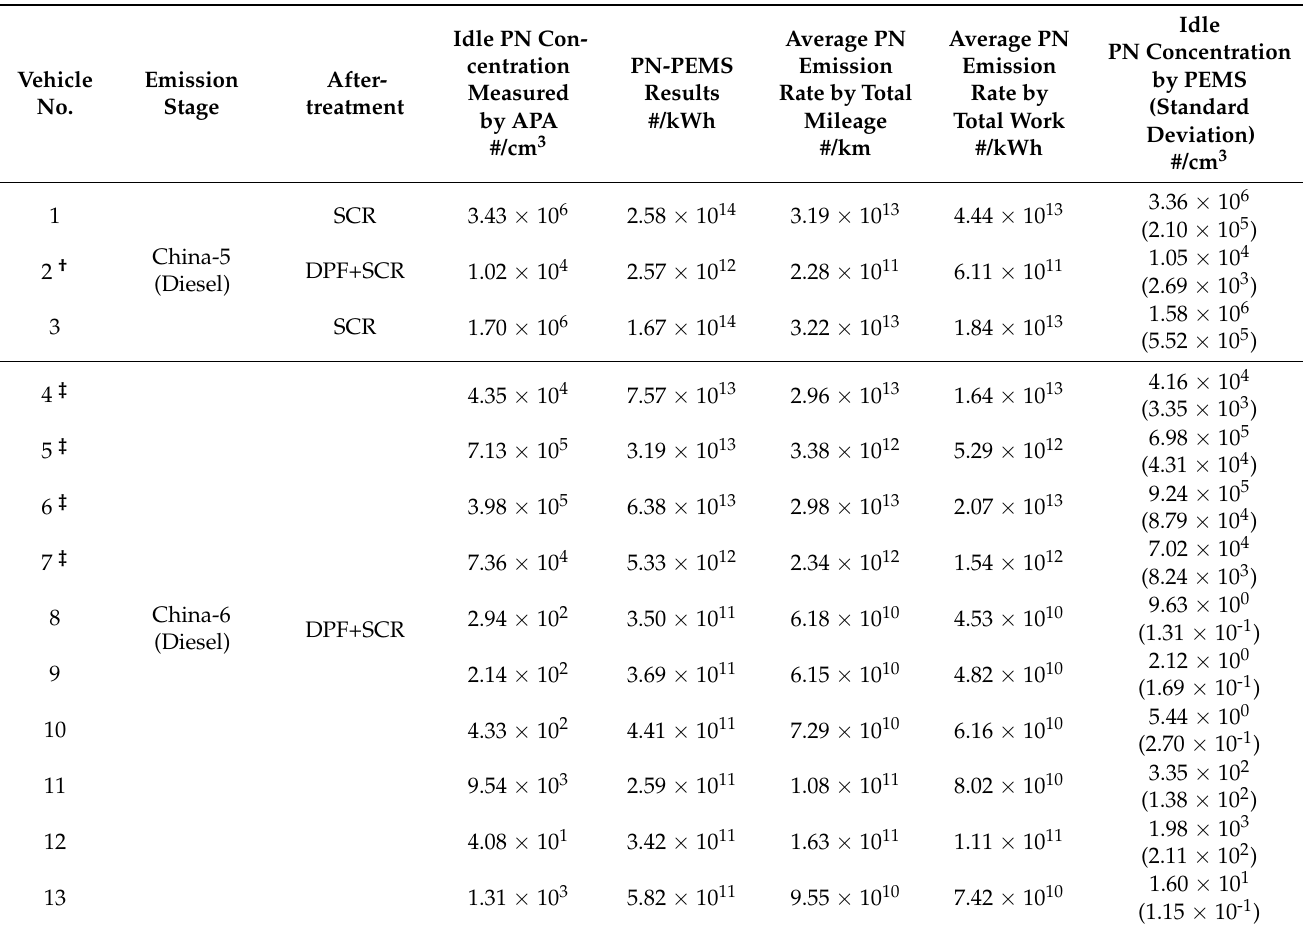
Table A3. Idle PN and PN-PEMS testing results of selected testing